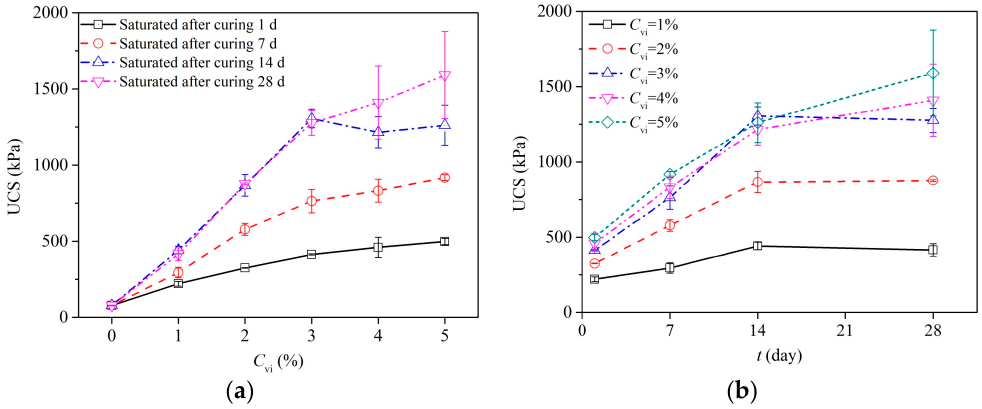
Figure 7. Uniaxial compressive strength (UCS) of saturated untreated and cement-treated GRSs at various cement contents and curing times. ( a ) Changes in UCS with cement content at various curing times; ( b ) Changes in UCS with curing time at various cement contents.